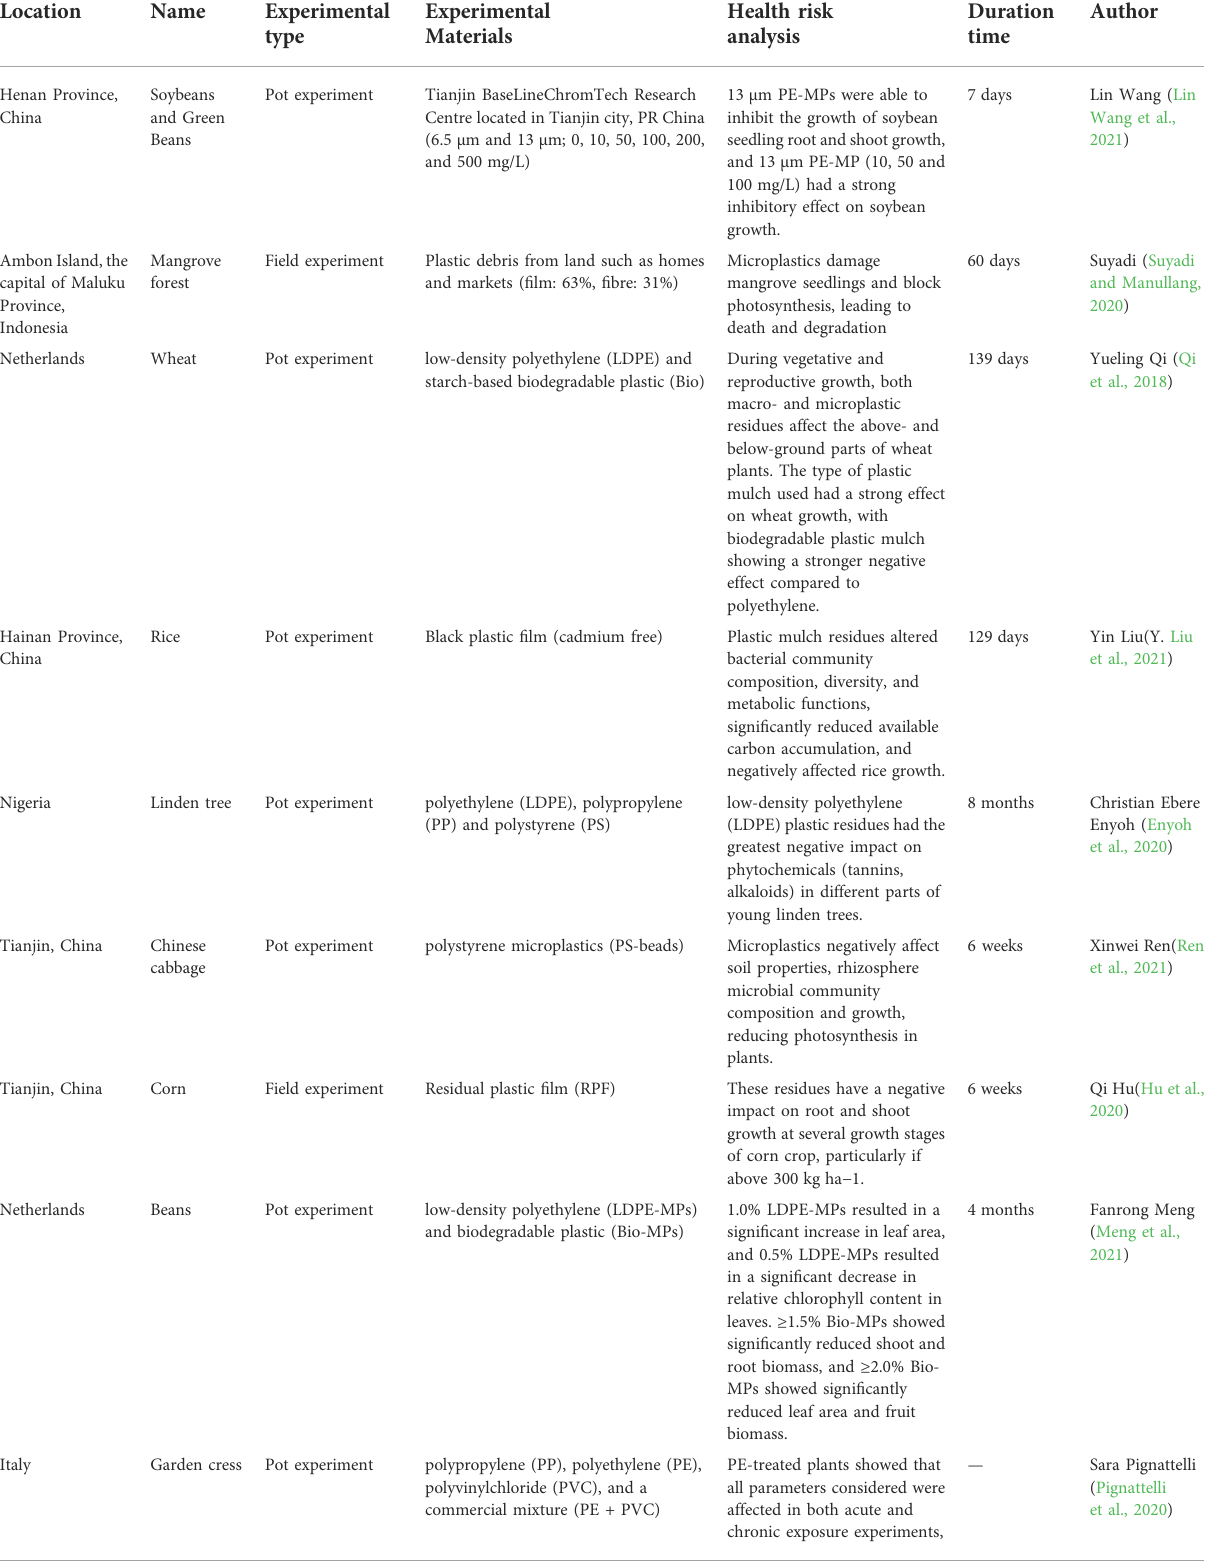
TABLE 4 Responses of soil MPs to